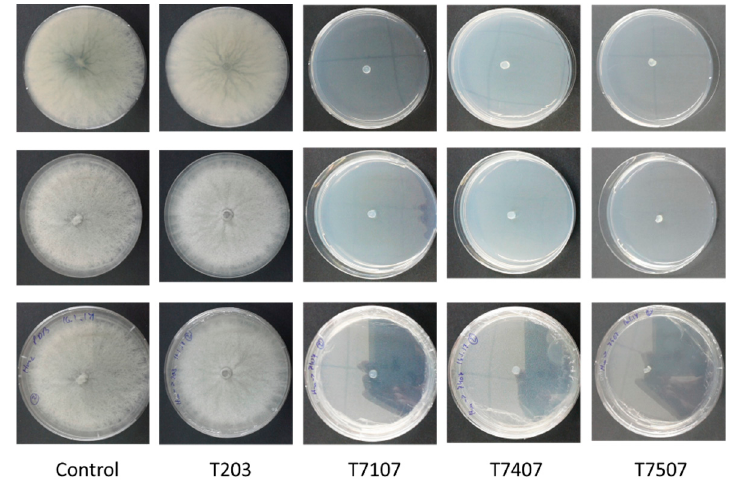
Figure 3. M. maydis vitality following incubation in the growth fluid of Trichoderma isolates. The Trichoderma isolates are T. asperelloides (T203), Trichoderma sp. (T7107), and T. longibrachiatum (T7407 and T7507). One disk of each of the treatments, described in Figure 2, was transferred to a PDA plate, and the plates were incubated for 6 days. The control is regular PDA medium M. maydis cultures maintained at the same conditions.